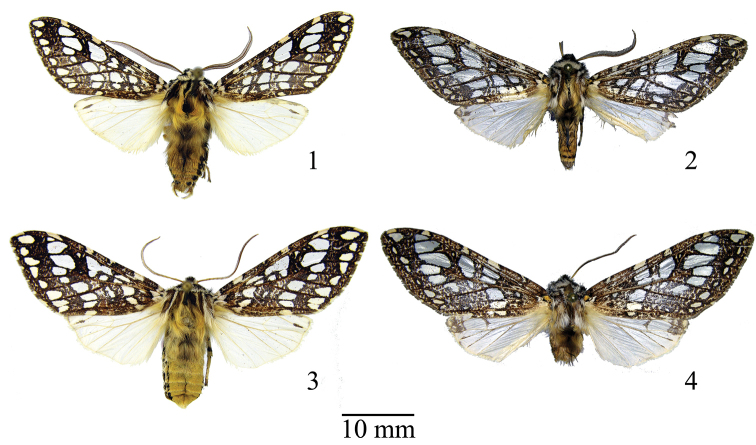
Habitus of Lophocampa species: 1Lophocampaazuayensis sp. n., holotype, male 2Lophocampacarpishensis sp. n., holotype, male 3Lophocampaazuayensis sp. n., paratype, female 4Lophocampacarpishensis sp. n., paratype, female.